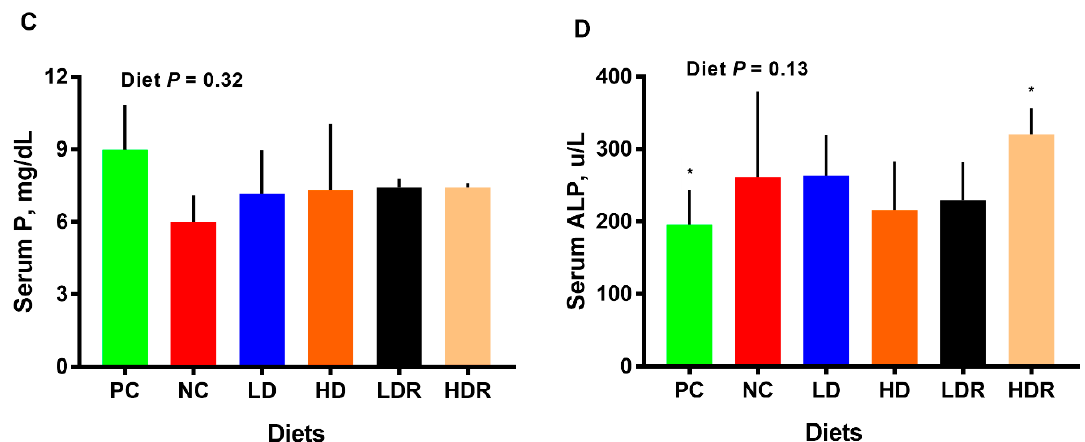
Figure 2. Serum metabolites and hormones in pigs fed with low-protein diets supplemented with a corn-expressed phytase. ( A ) serum osteocalcin, ( B ) serum calcium (Ca), ( C ) serum phosphorus (P), ( D ) serum alkaline phosphatase (ALP). Pigs are grouped based on their dietary treatments: PC (positive control): normal protein, adequate Ca and available phosphorous (aP), no corn-expressed phytase (CEP) added; NC (negative control): low protein, adequate Ca and aP, no CEP added; LD: NC + CEP added at low dose, i.e., 2000 FTU/kg of diet; HD: NC + CEP added at high dose, i.e., 4000 FTU/kg of diet; LDR: LD with reduced calcium (Ca) and phosphorus (P); HDR: HD with reduced Ca and P. The values are means ± standard errors of means. Different letters in the bar plots indicate significant differences ( p ≤ 0.05, Tukey’s test) and common superscript symbols indicate a trend (0.05 < p ≤ 0.1). n = 7–8 for each dietary group.